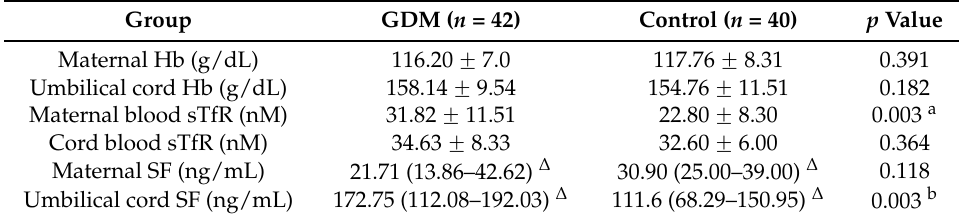
Table 2. Comparison of iron metabolism indicators in the maternal–fetal interface with and without GDM.